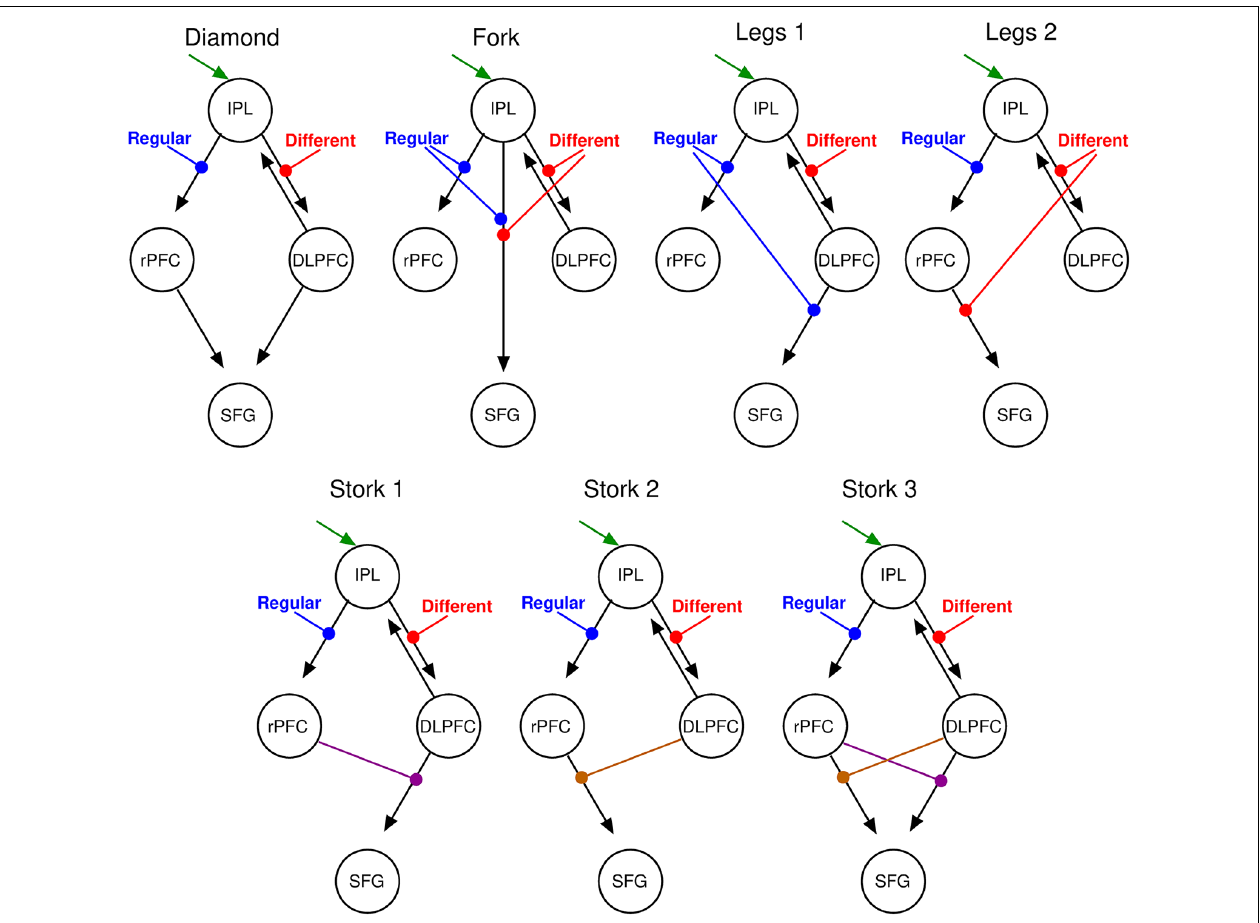
FIGURE 5 | DCM parsimonious and non-redundant model space. Stimulus inputs arrive via the IPL (green arrow) and propagate, via intrinsic connections (black arrows) to the rPFC and the dorsolateral PFC (DLPFC). Each of these intrinsic connections is perturbed by experimental inputs: different (red) and Regular (blue) stimulus trials that account for the corresponding effects in the SPM contrasts. From left to right, top motifs are linear serial (Diamond), parallel (Fork), hierarchical with the regular modulation at the higher level (Legs 1), and a hierarchical with the different modulation at the higher level (Legs 2). Bottom motifs are hierarchical and nonlinear. From left to right, regular modulation is at the top of the hierarchy (Stork 1), different modulation is at the top of the hierarchy (Stork 2), and the double non-linear model in which both modulations occupy top and low hierarchy positions at the different interactions (Stork 3). Please refer to the Supplementary Material for further discussion on the model